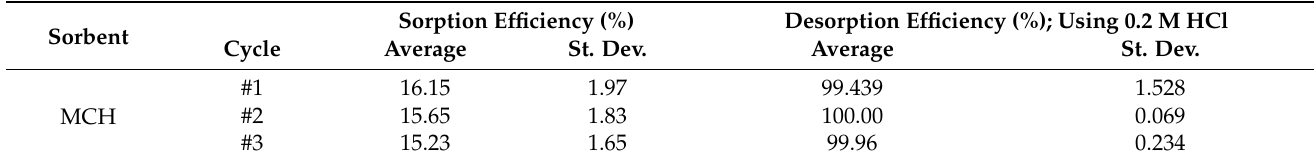
Table 5. Sorbent recycling (MCH and MCH-ATA) for Cd(II) sorption with sorption and desorption